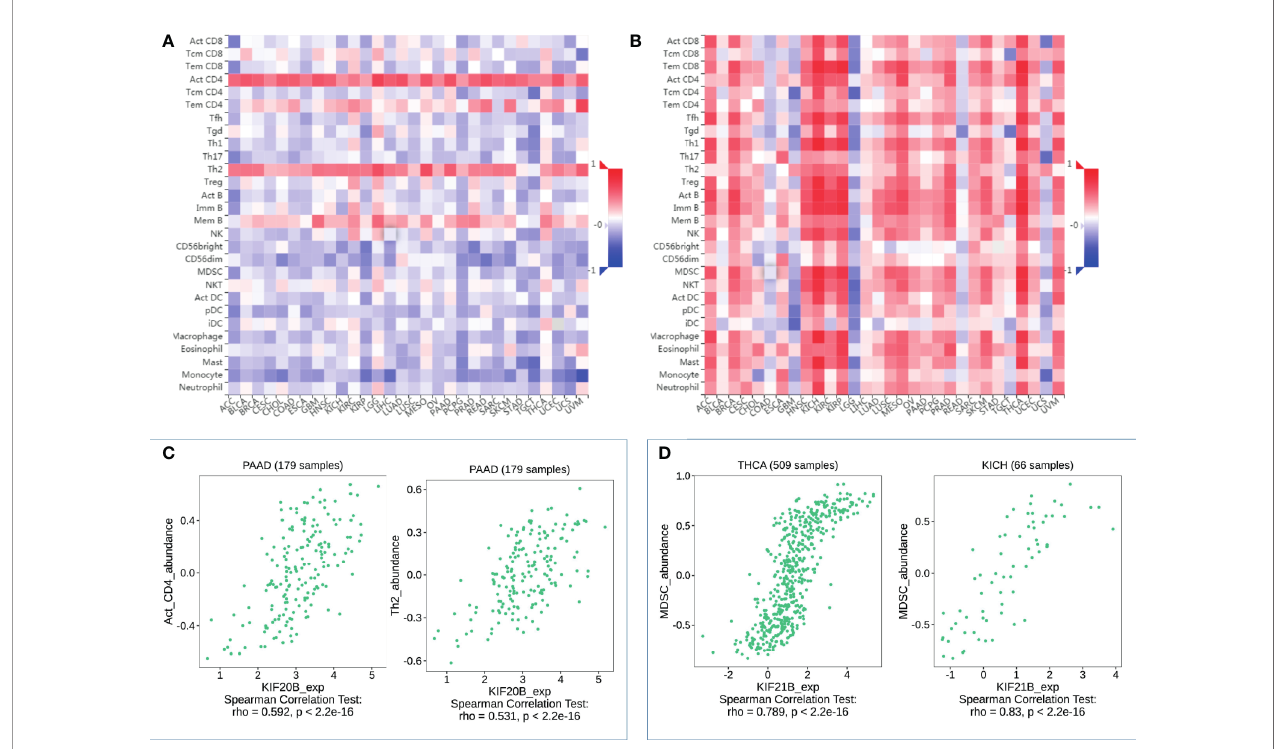
FIGURE 8 | Correlation analysis of KIF20B, KIF21B level and immune cells in fi ltration levels across human cancers using the TISIDB database. (A) Relations between abundance of tumor-in fi ltrating lymphocytes (TILs) and expression of KIF20B. (B) Relations between abundance of tumor-in fi ltrating lymphocytes (TILs) and expression of KIF21B (C) KIF20B signi fi cantly correlated with abundance of Act_CD4 and Th2 in PDAC. (D) KIF21B signi fi cantly correlated with abundance of MDSC in TICH and KICH.